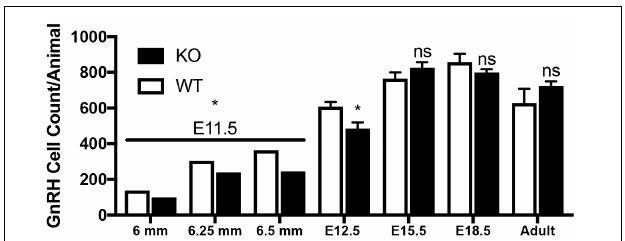
FIGURE 7 | Lack of GPR37 delays GnRH development. Significantly fewer GnRH positive neurons were observed at E11.5 (N: 6 WT and 6 KO; p = 0.0034 paired t -test) and E12.5 (N: 3 WT and 4 K, p = 0.041 paired t -test). By E15.5 (N: 4 WT and 4 KO), and thereafter (E18.5, N: 3 WT, 4 KO, and Adult, N: 3 WT and 3 KO), no differences in the number GnRH neurons was detected ( p = 0.231, p = 0.266, p = 0.315, respectively, One way-ANOVA). ∗ p < 0.05, ns, not significant, p > 0.05.